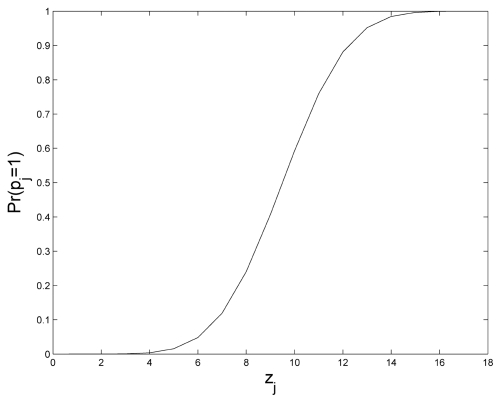

Pr(pj = 1),
as a function of sj, the number of
+1 elements in .The total number of elements in ,
r = 18.